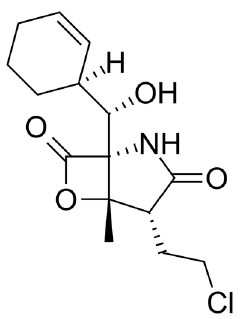
Figure 1. The chemical structure of salinosporamide A.